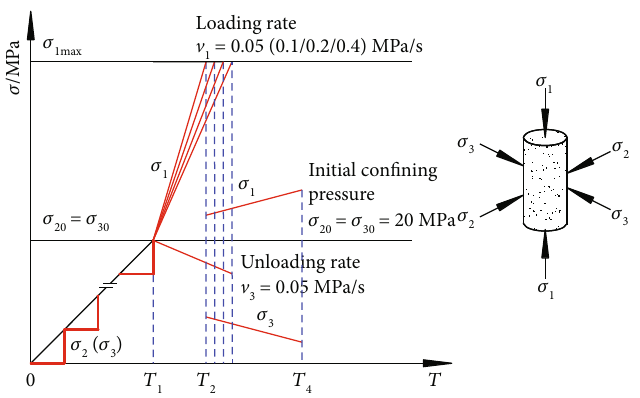
Figure 3: Stress path of unloading con fi ning pressure and loading axial pressure. Table 1: Test results.